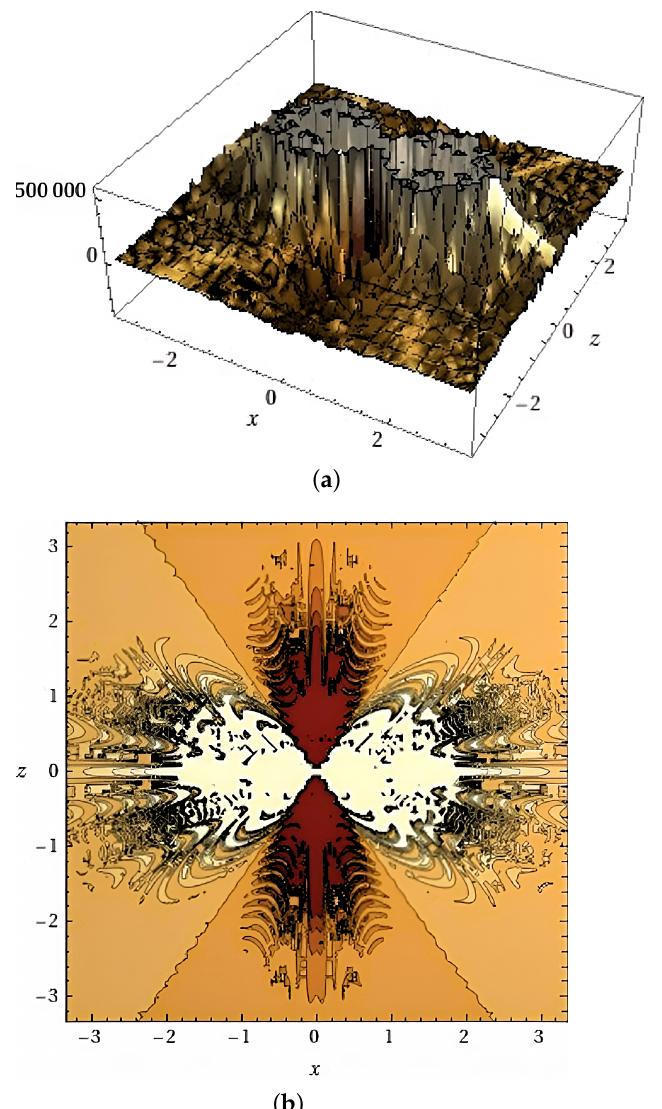
Figure 2. ( a ) 2D plot of the EM intensity distribution (in a.u.) below and above the device surface,